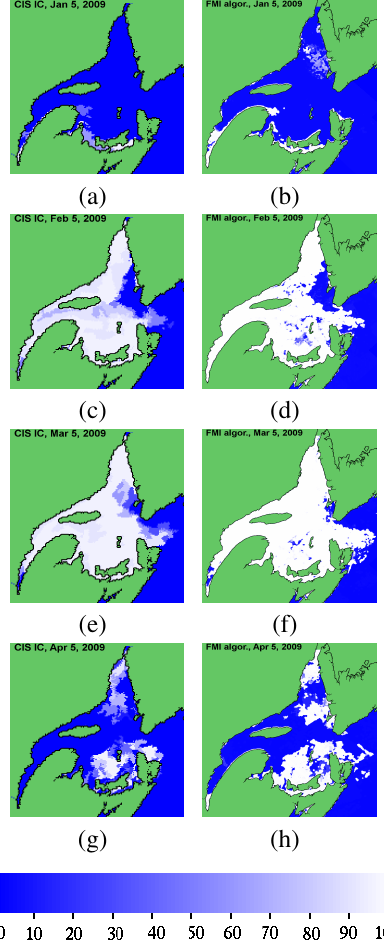
Fig. 12. Ice concentration for the 5 January (a-b), 5 February (c-d), 5 March (e-f), and 5 April (g-h) 2009 Fig. 11. Ice concentration for the 5 January (a-b), 5 February (c-d), 5 March (e-f), and 5 April (g-h) 2003 Fig. 12. Ice concentrations for the 5 January (a–b) , 5 February (c– Fig. 11. Ice concentrations for the 5 January (a–b) , 5 February (c– from the CIS ice charts (left column) and based on our SAR algorithm (right column). from the CIS ice charts (left column) and based on our SAR algorithm (right column). d) , 5 March (e–f) , and 5 April (g–h) 2009 from the CIS ice charts d) , 5 March (e–f) , and 5 April (g–h) 2003 from the CIS ice charts (left column) and based on our SAR algorithm (right (left column) and based on our SAR algorithm (right column).